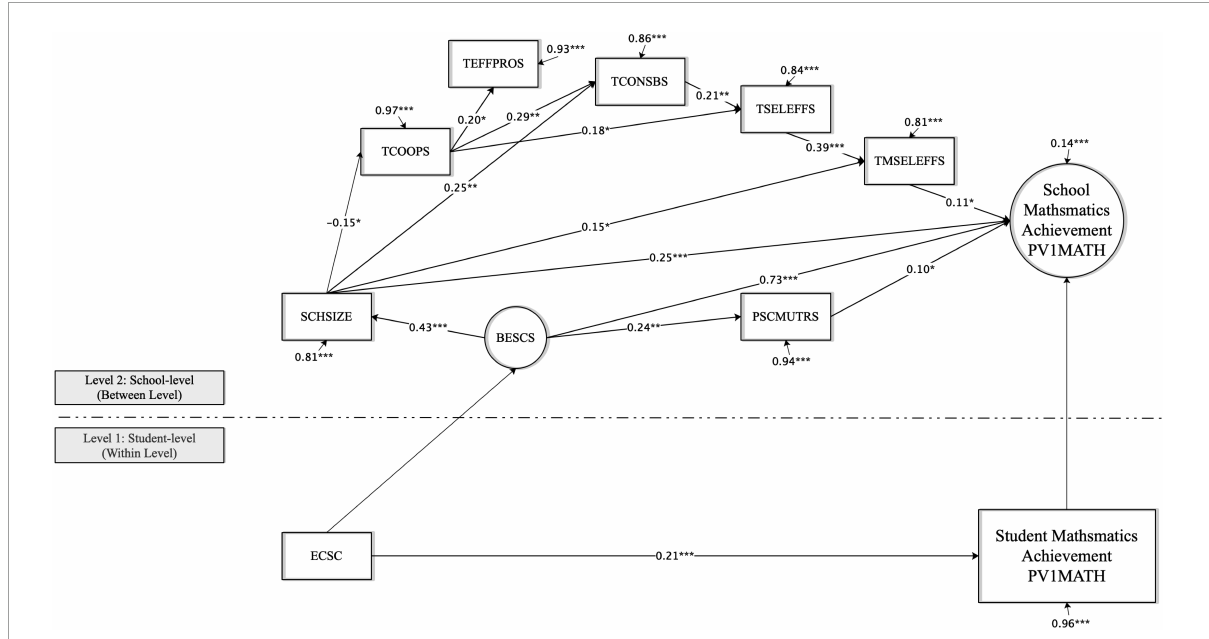
FIGURE6 The standardized model results of the relationships between teacher characteristics and student mathematics achievement at the student- and school-level. *** P < 0.001, ** P < 0.01, * P < 0.05.